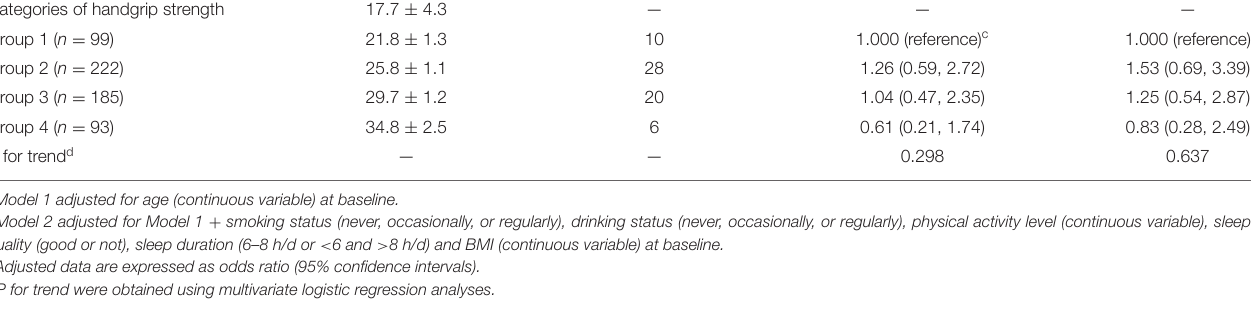
50) during the 1-year ≥